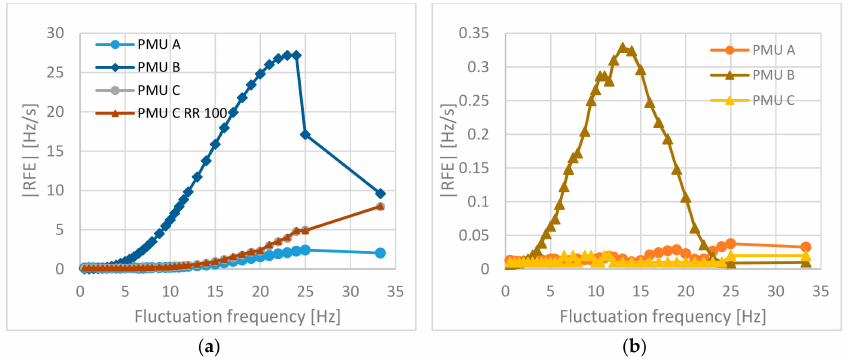
Figure 11. RFE results for the PMUs with P ( a ) and M ( b )